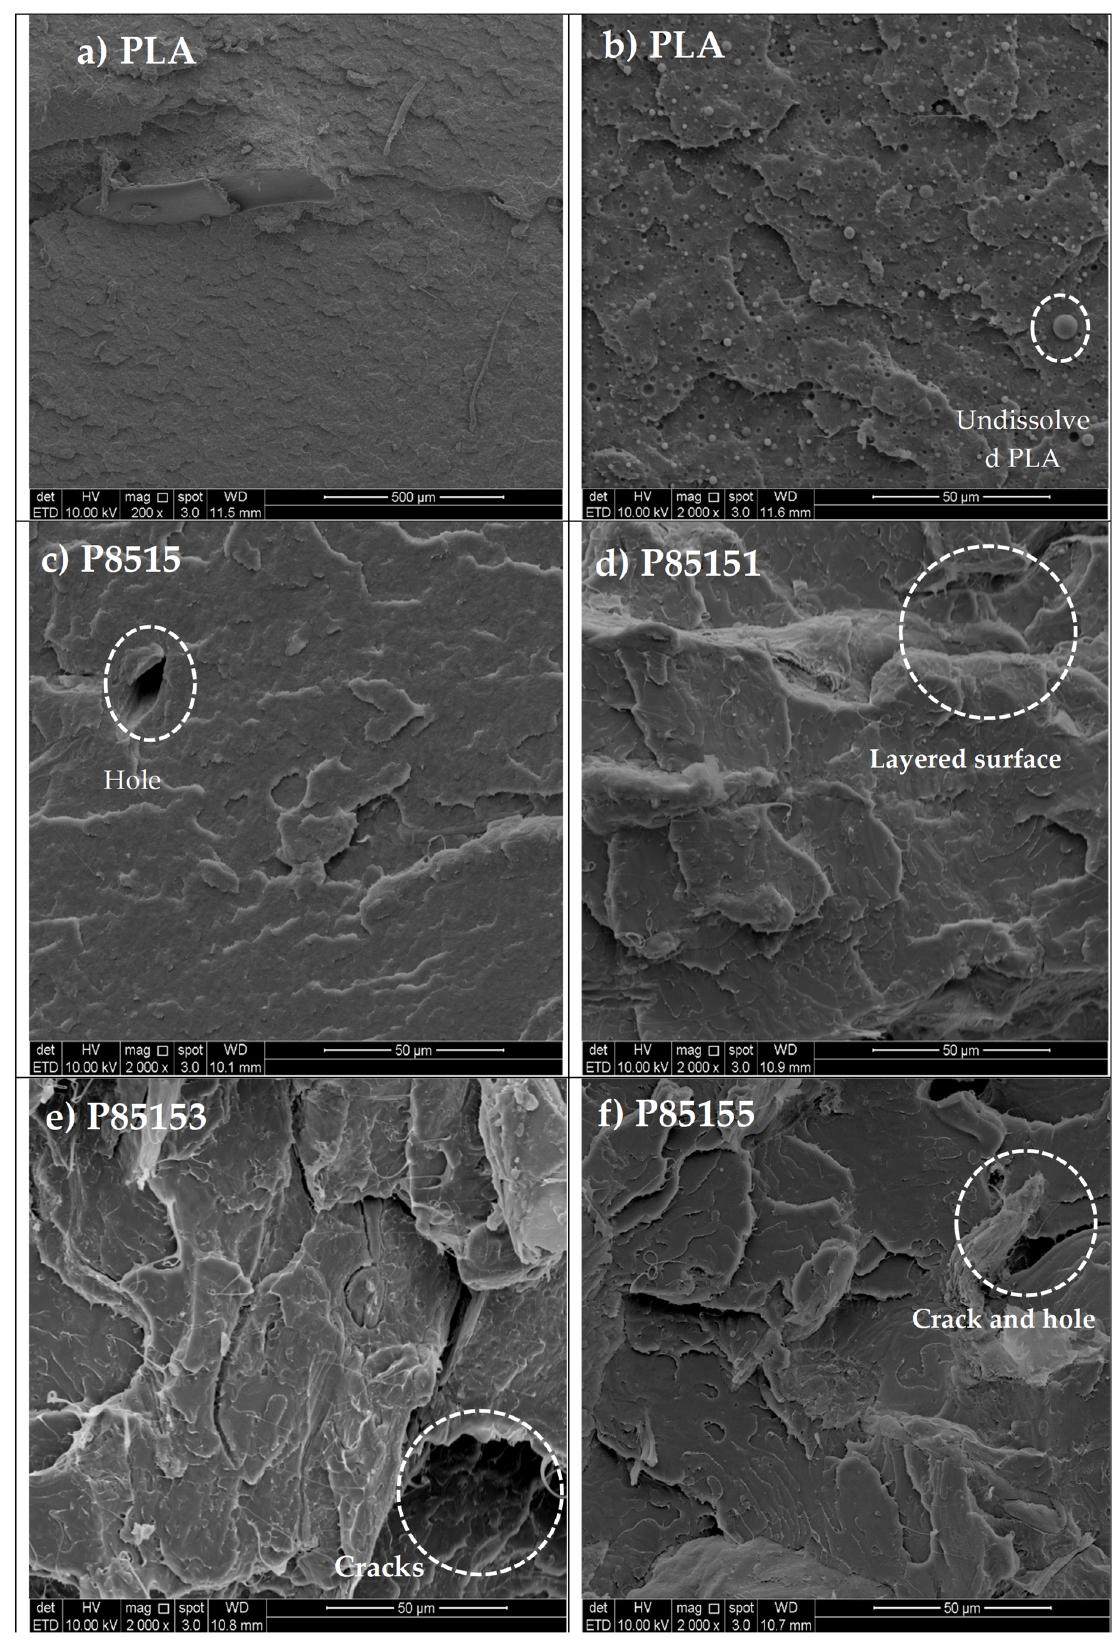
Figure 7. Tensile fractured surface SEM images for neat PLA, P8515, P85151, P85153, and P85155 biocomposites.